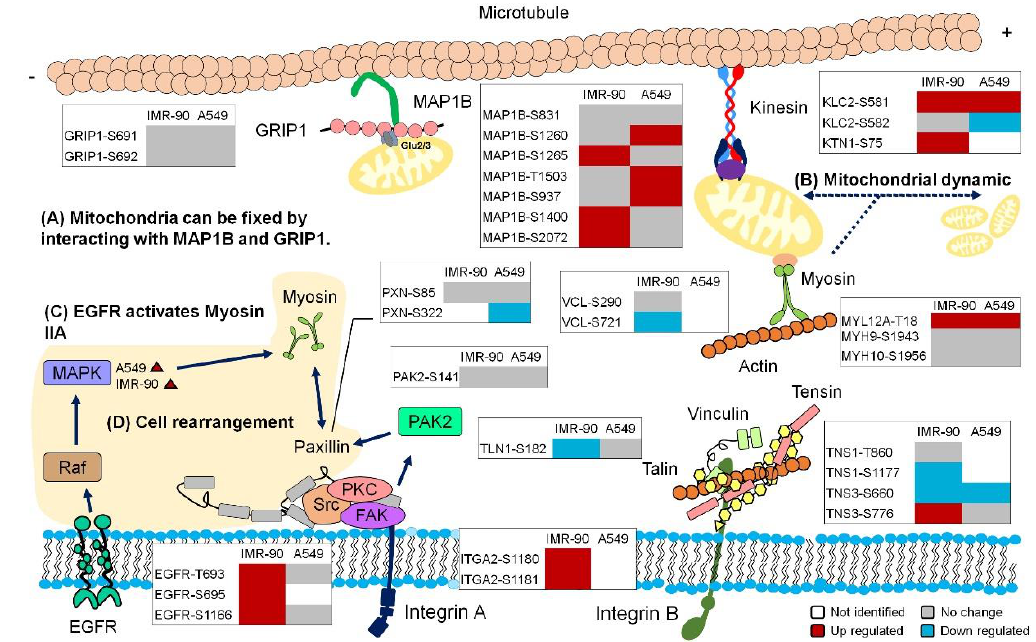
Figure 7. Cyclic stretching induces cellular rearrangement and enhances mitochondrial